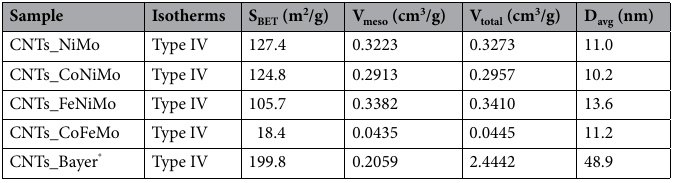
Table 7. Summary of surface area and porosity of CNTs synthesized with different catalysts.